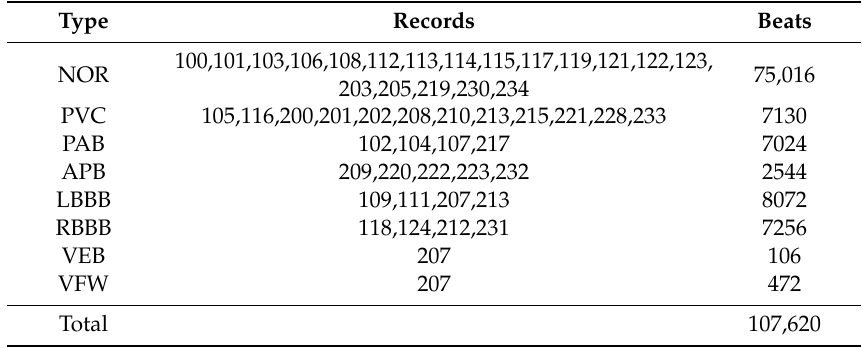
Table 1. A summary table of ECG signal description from the MIT-BIH arrhythmia